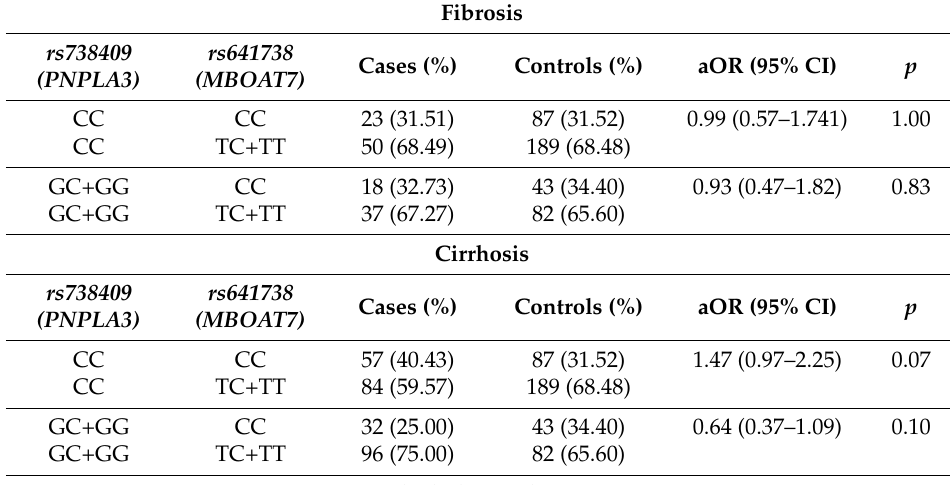
Table 5. Combined analysis of PNPLA3 and MBOAT7